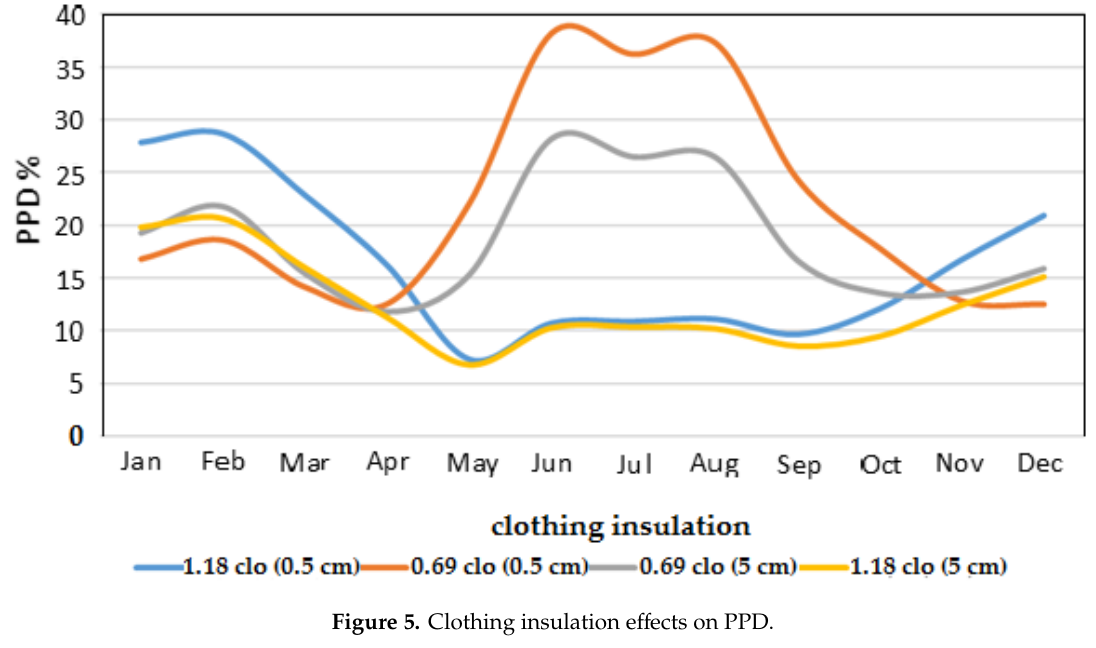
Figure 5. Clothing insulation effects on PPD.